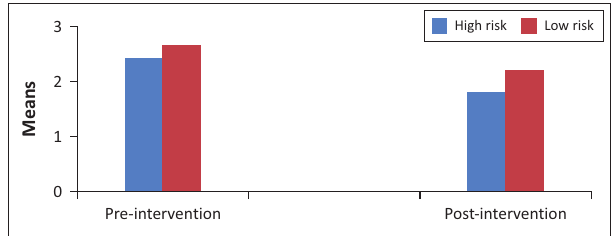
FIGURE 1: Pre- and post-intervention results regarding students’ extensive reading